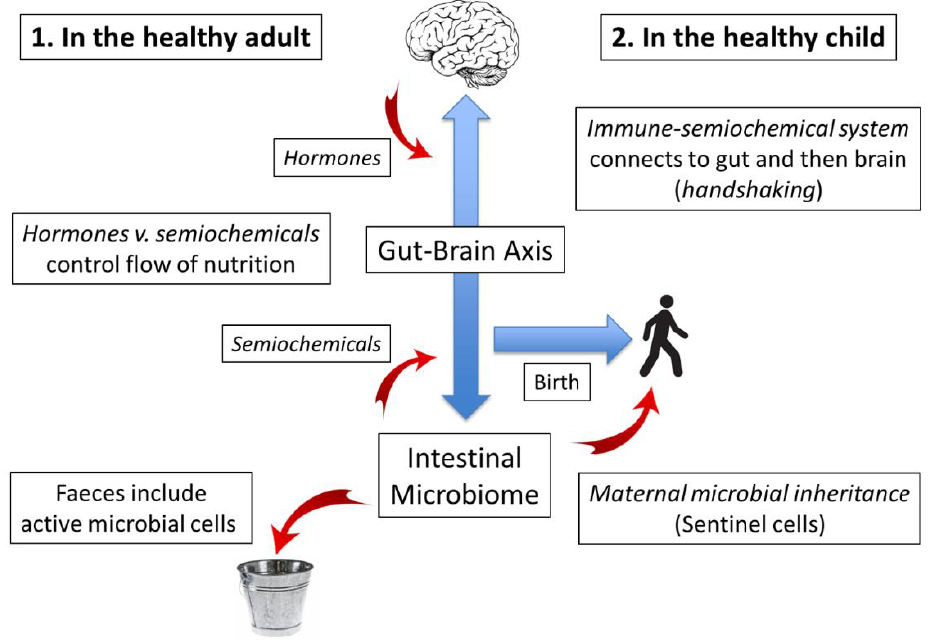
Figure 1. The healthy gut – brain axis (a virtuous circle, [13]). Left hand side: Illustrates the operation of the gut – brain axis following input from both brain (hormones) and microbiome (semiochemicals) in the healthy adult. High faecal energy output with viable microbial cells. Right hand side: Maternal microbes are passed from mother to child, possibly including hypothetical immune-calibrating “sentinel cells”. Once transferred, the fully functioning microbiome establishes communication with the gut (handshaking), and hence supplies interoceptive input to the brain.